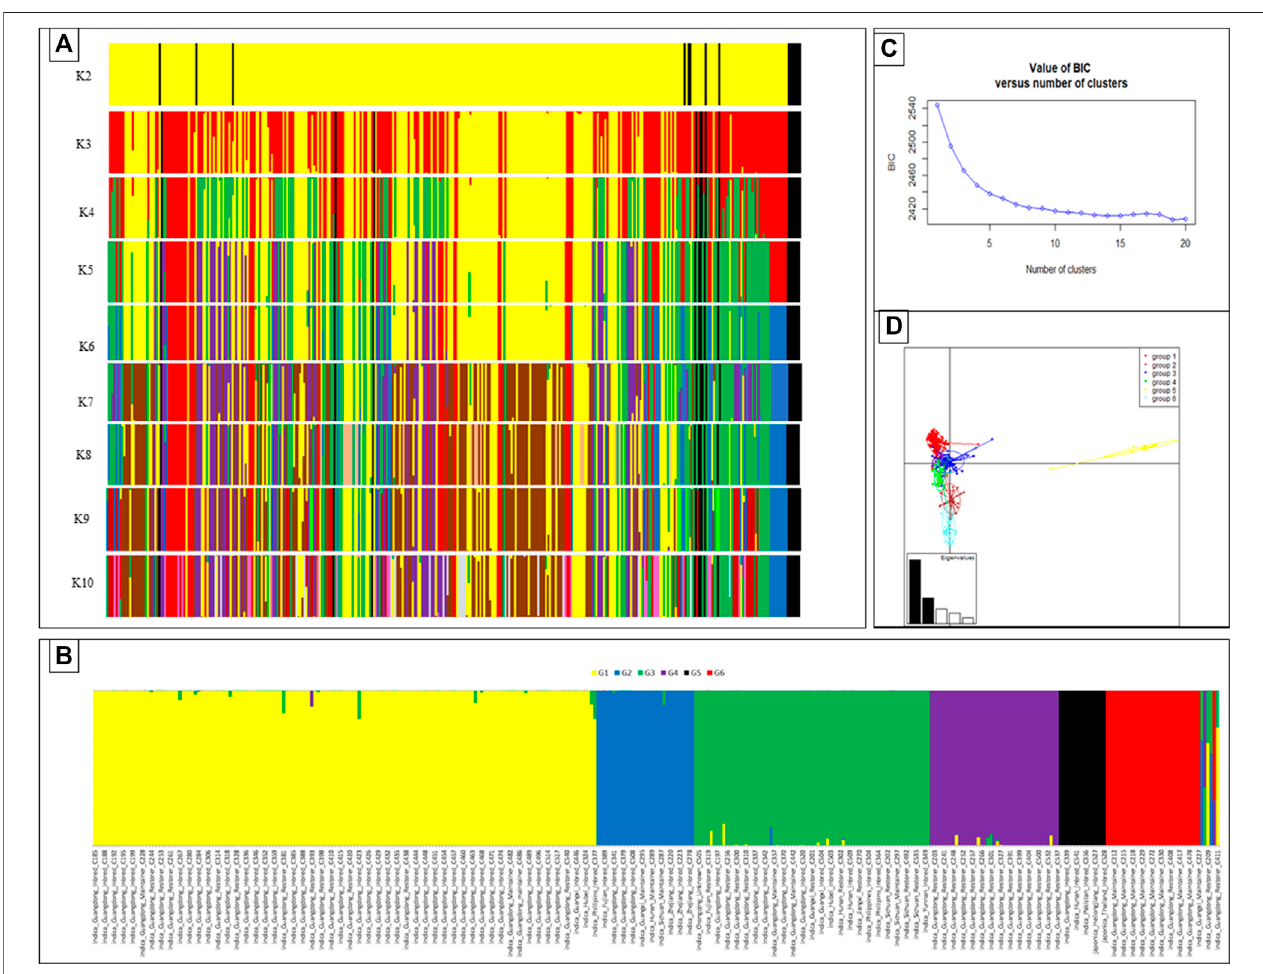
FIGURE 1 | DAPC of rice accessions collected from different provinces in South China, Philippines, Thailand, Iran, Pakistan, and United States. Possible DAPC clusters ranging from K2 to K10 (A) . The cluster of 359 rice genotypes of diverse origins into different genetic groups set a siding geographical origin for the optimal K-value ( K = 6) in DAPC (B) . Bayesian information criteria (BIC) supported six distinct genetic groups (C) . The Eigen values of the analysis suggest that the fi rst two components explained the maximum genetic structure of the data set. Scatter plot of the 359 accessions divided into six genetic groups (D) .